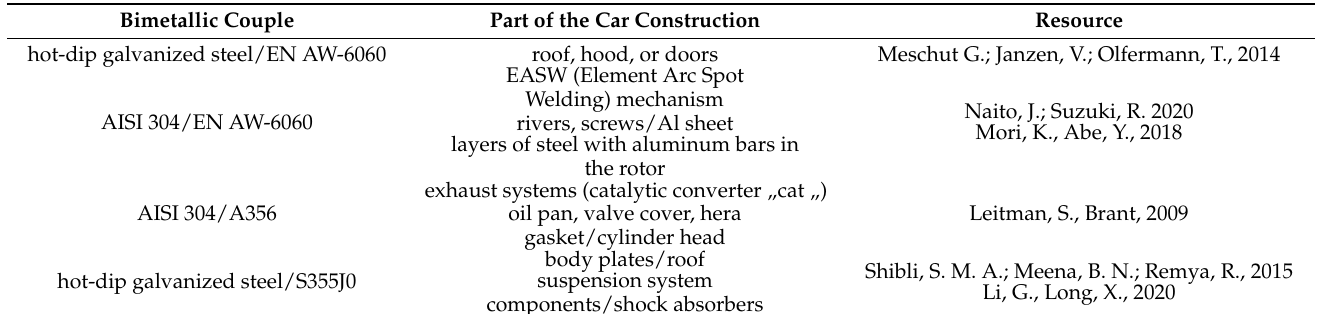
Table 3. Couples of material samples assembled based on real joints in car construction.